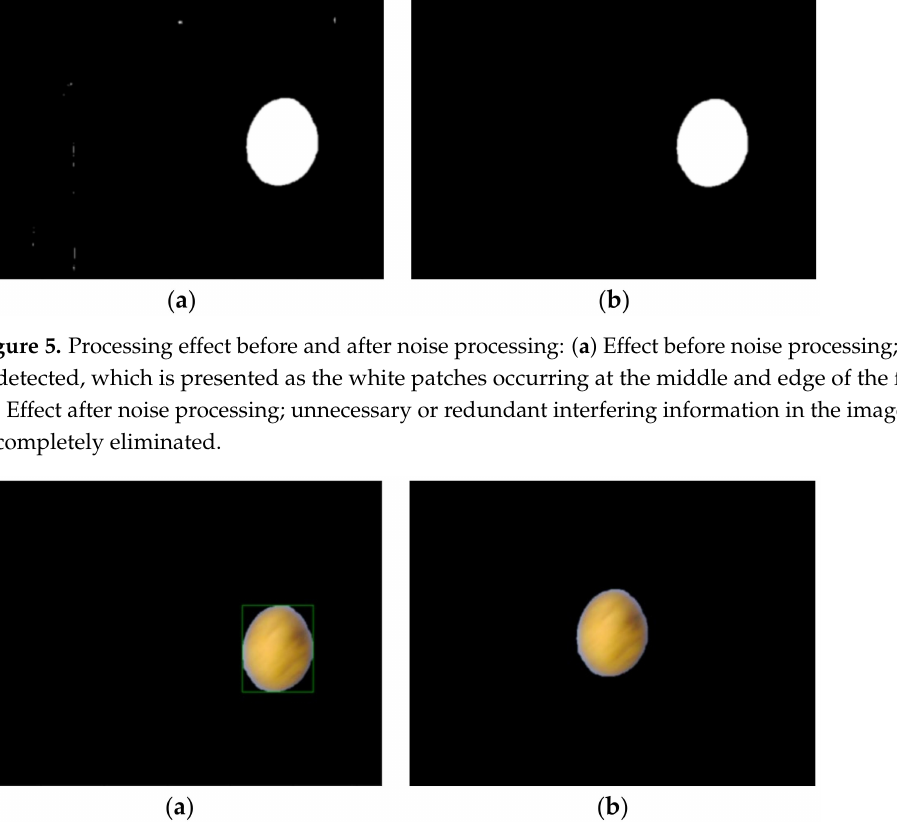
Figure 6. Processing effect before and after the pattern centering conversion: ( a ) Effect before centering transformation; ( b ) Effect after centering